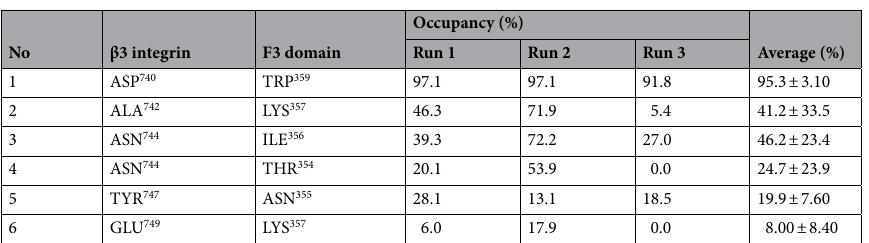
Table 1. Interface H-bonds between binding site residue pairs of three equilibrated complexes. The H-bond occupancies in column 4–6 showed a mean over 40 ns simulation time of a run. Data from three runs were averaged and shown in means ± S.D. (column